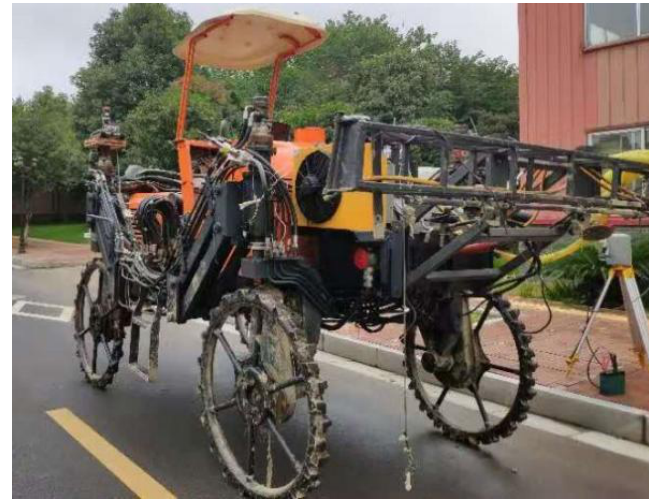
Figure 1. Four-wheel independent-steering paddy field machinery.